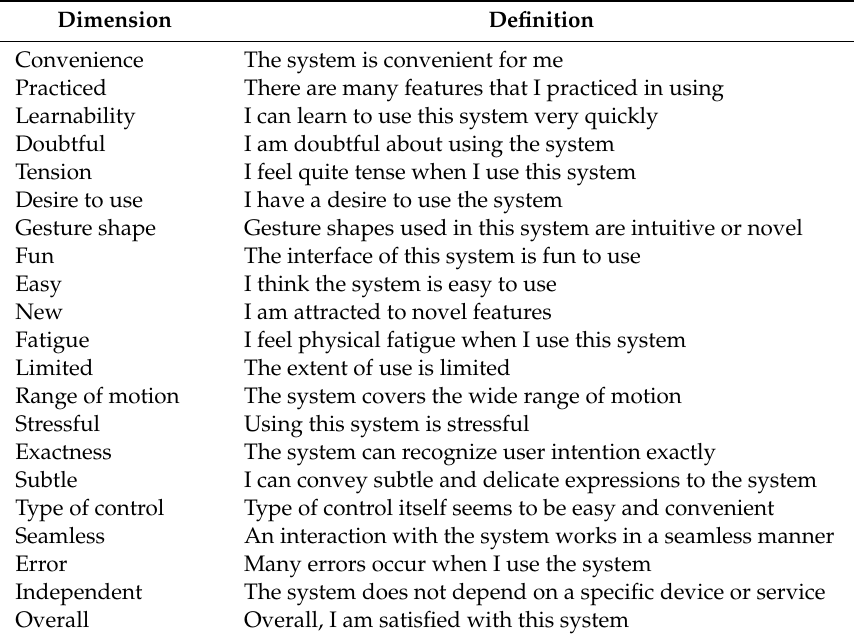
Table 5. Influential value dimensions and their definitions.